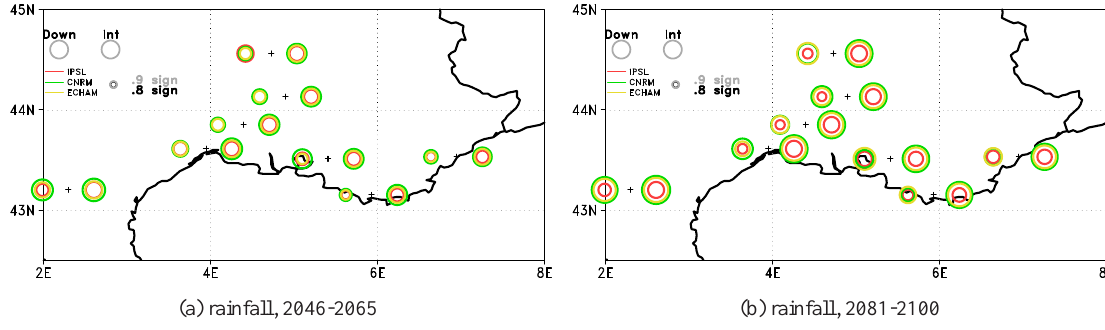
Fig. 10: Same as Fig. 6 but for daily rainfall with processing 1.